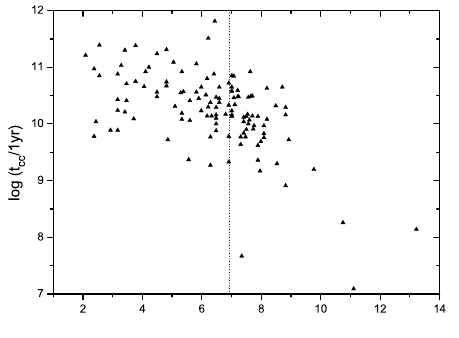
Figure 8: Age-Metallicity behavior, using the abso- lute age values extimated by Dotter et al. (2010). PCC clusters are indicated by grey squares, suspected PCC ones by white triangles.